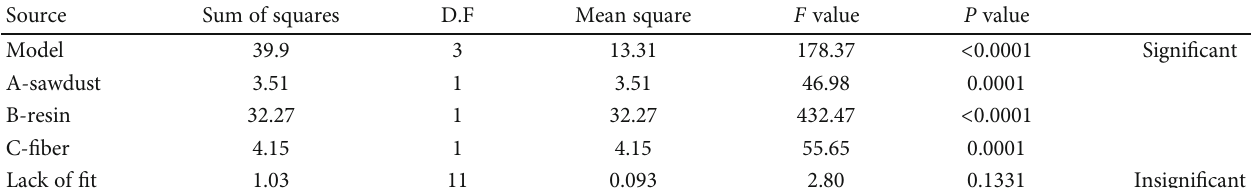
Figure 4: E ff ect of fi bres, sawdust, and resin on compressive strength of the Table 4: ANOVA table for composite compressive strength.